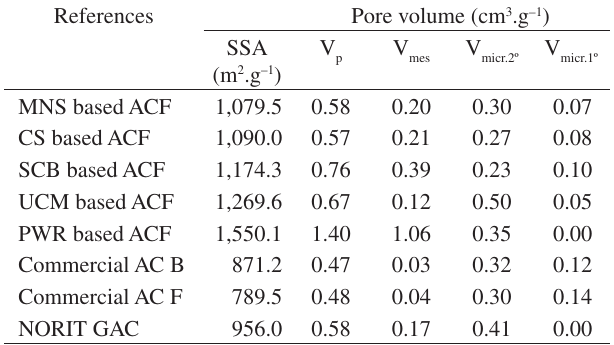
Table 2. Textural properties of the commercial activated carbons and activated carbon